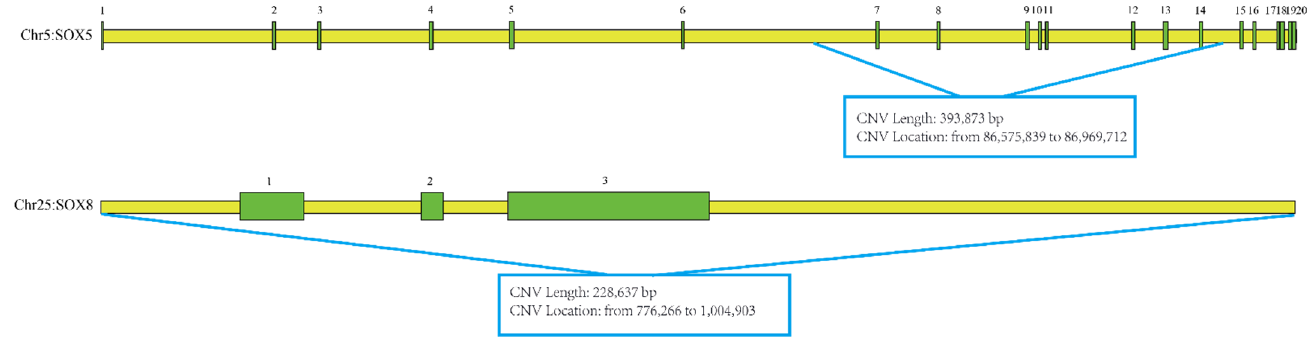
Figure 1. Information on CNVs of SOX5 and SOX8 genes. The numbers from 1 to 20 denote the exons. Table 1. Primer